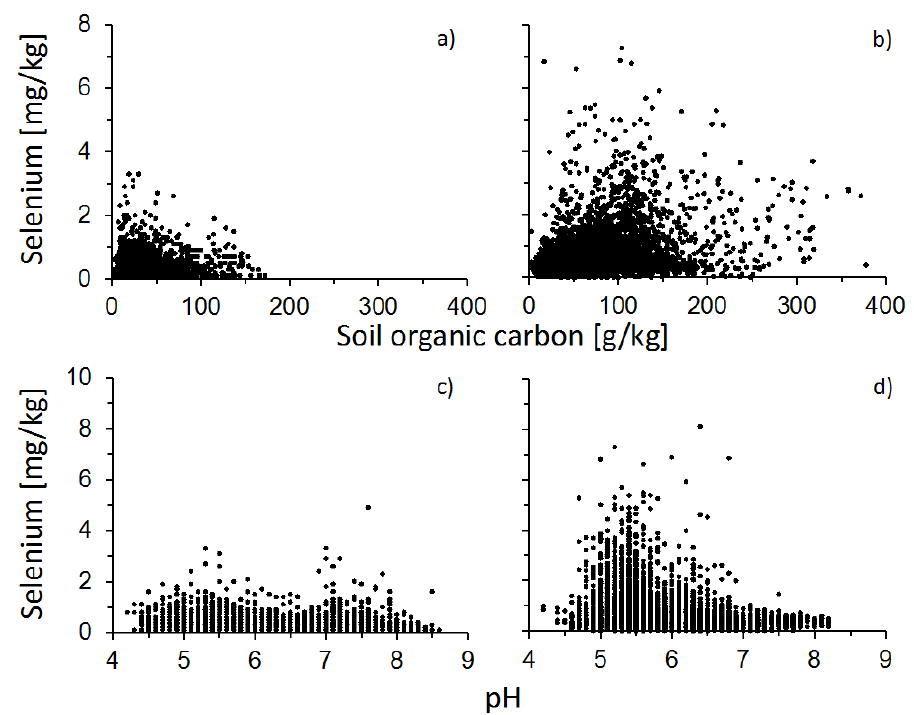
Figure 2. Scatter plot illustrating large-scale nonlinearities between soil Se and soil organic carbon ( a , b ) and soil pH ( c , d ) in the United States (a,c) and Western Europe (b,d). Soil Se analyses were published by the USGS (2014) [155] and Reimann et al. (2014) [156] and the organic carbon and pH data were published by Hengl et al. (2014)